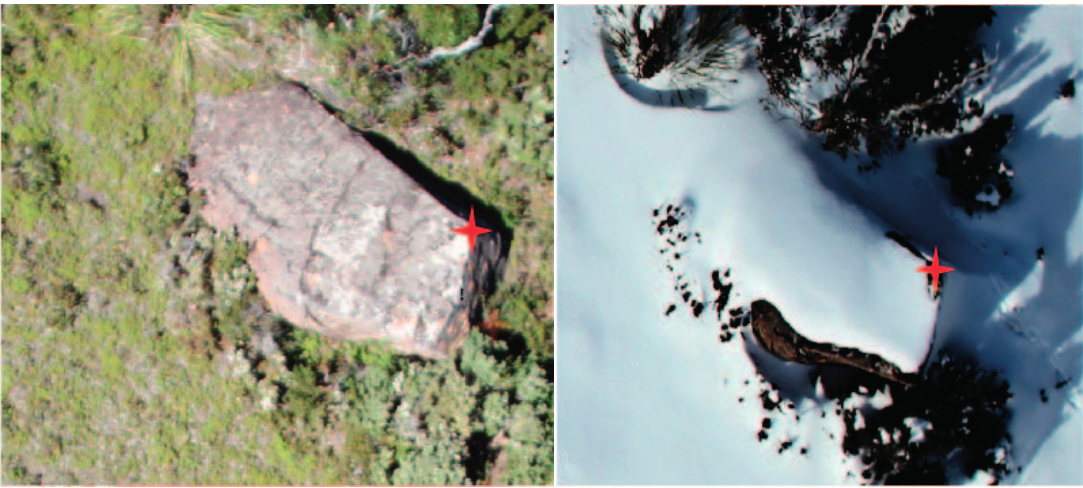
Figure 9. For co-registering the two datasets, we used the corner of a large boulder (red star) within the study site to estimate the translational components for the affine transformation.